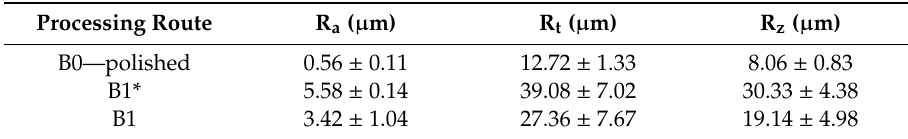
Table 1. Two-dimensional (2D) (R a , R t , R z ) parameters for the Ti23Zr25Nb (at.%) on different processing routes.